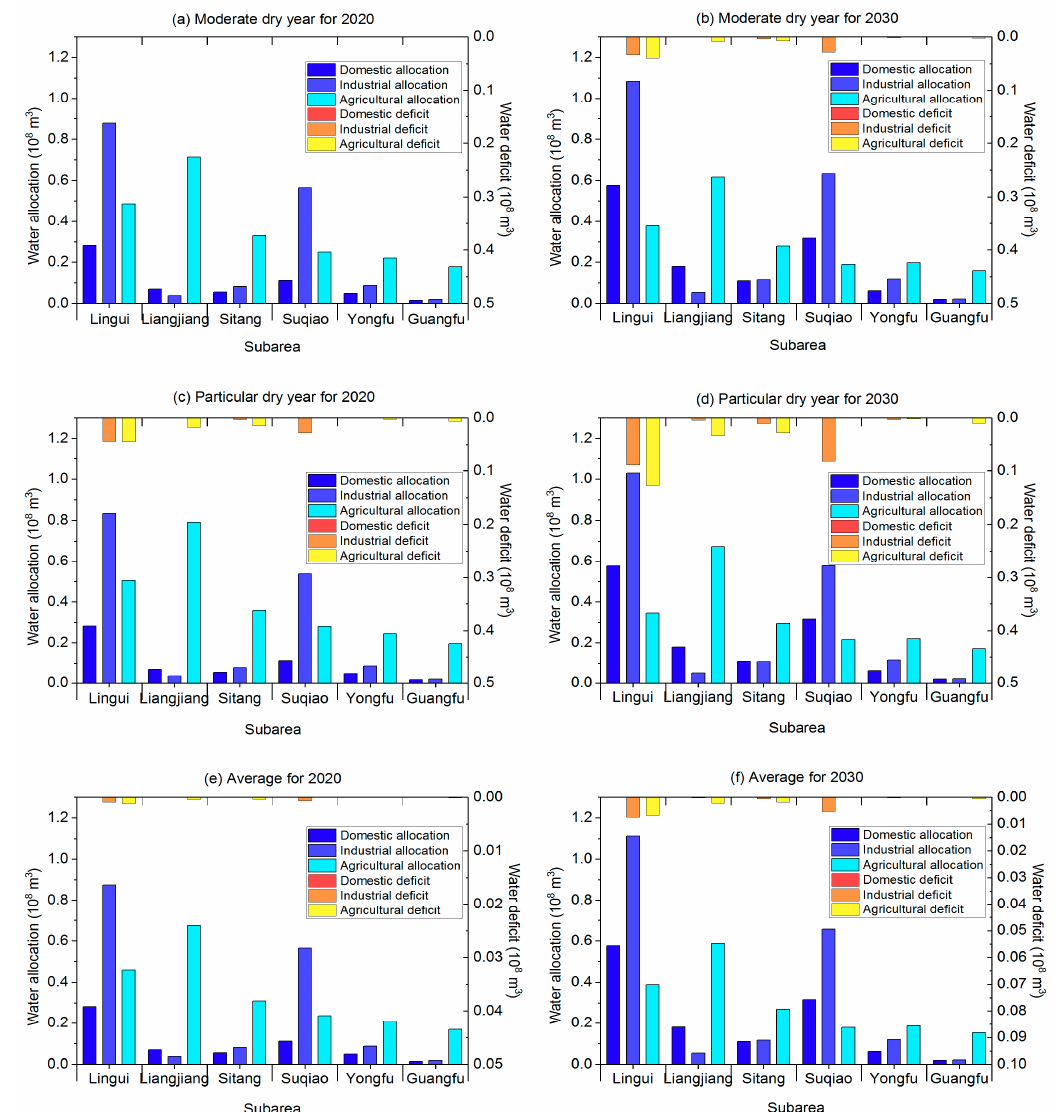
Figure 7. Optimal water allocation scheme for di ff erent water users under di ff erent scenarios.